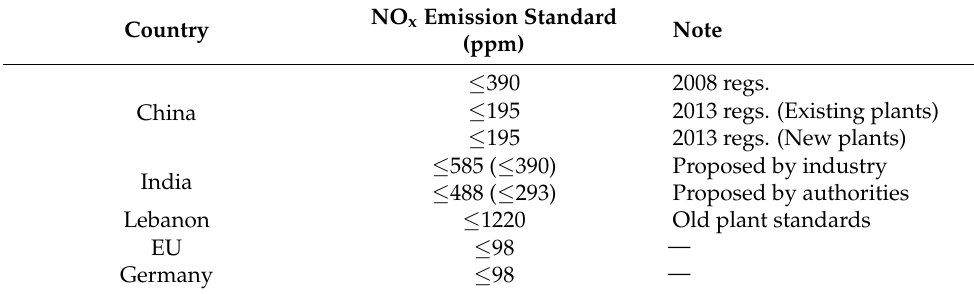
Table 1. NO x emission standard in each country (data taken from